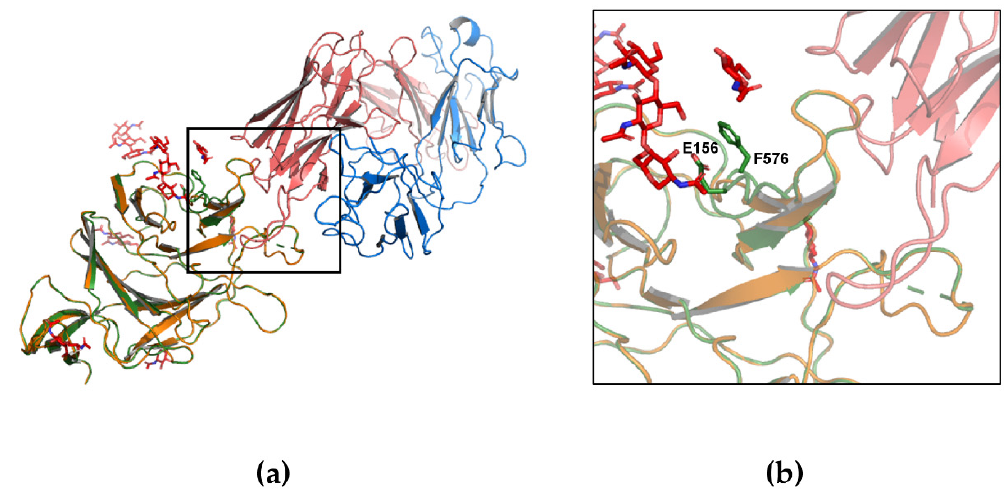
Figure 3. Comparison between the reference (chain A) and model Delta NTDs in complex with 4A8. ( a ) Cartoon model of the complex: reference and Delta NTDs are represented as green and orange cartoon models, respectively. A8 heavy and light chain are depicted with red and blue cartoons, respectively. ( b ) Detail of the NTD-4A8 antibody interface. The reference Spike residues that are deleted in the Delta variant are indicated as stick models and labelled. Glycans are displayed as red sticks models.